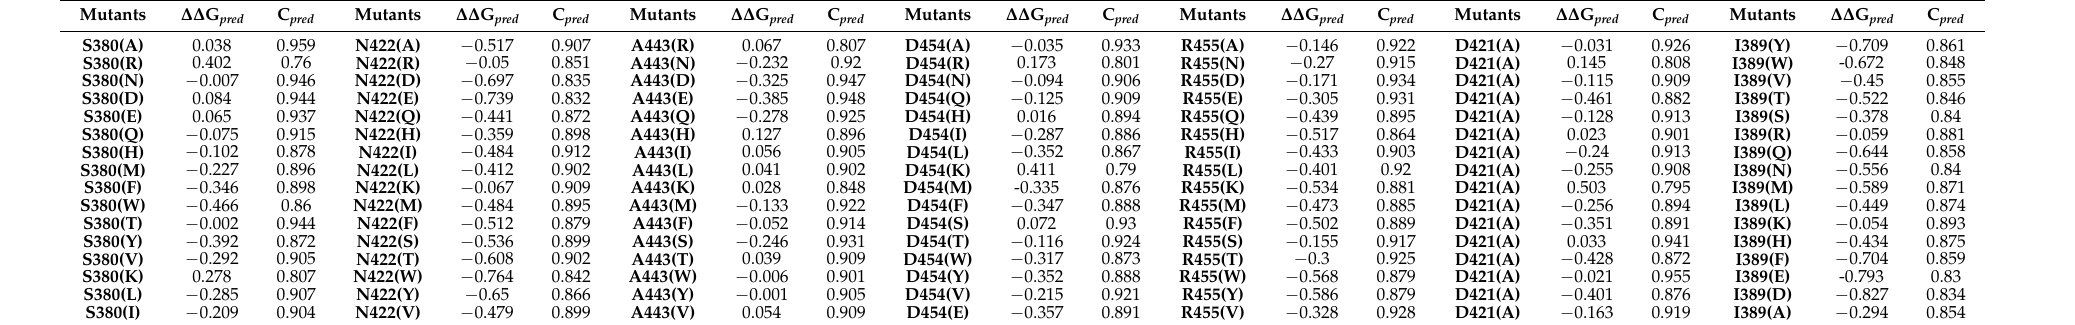
Table 1. Specific mutation evaluation using the MAESTRO